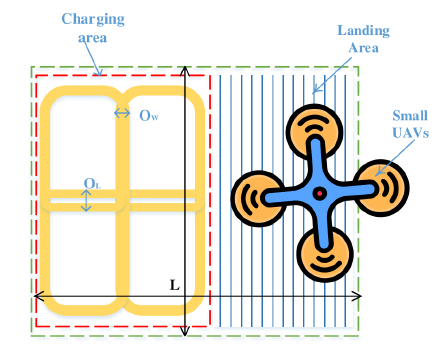
Figure 8. The WPT charging